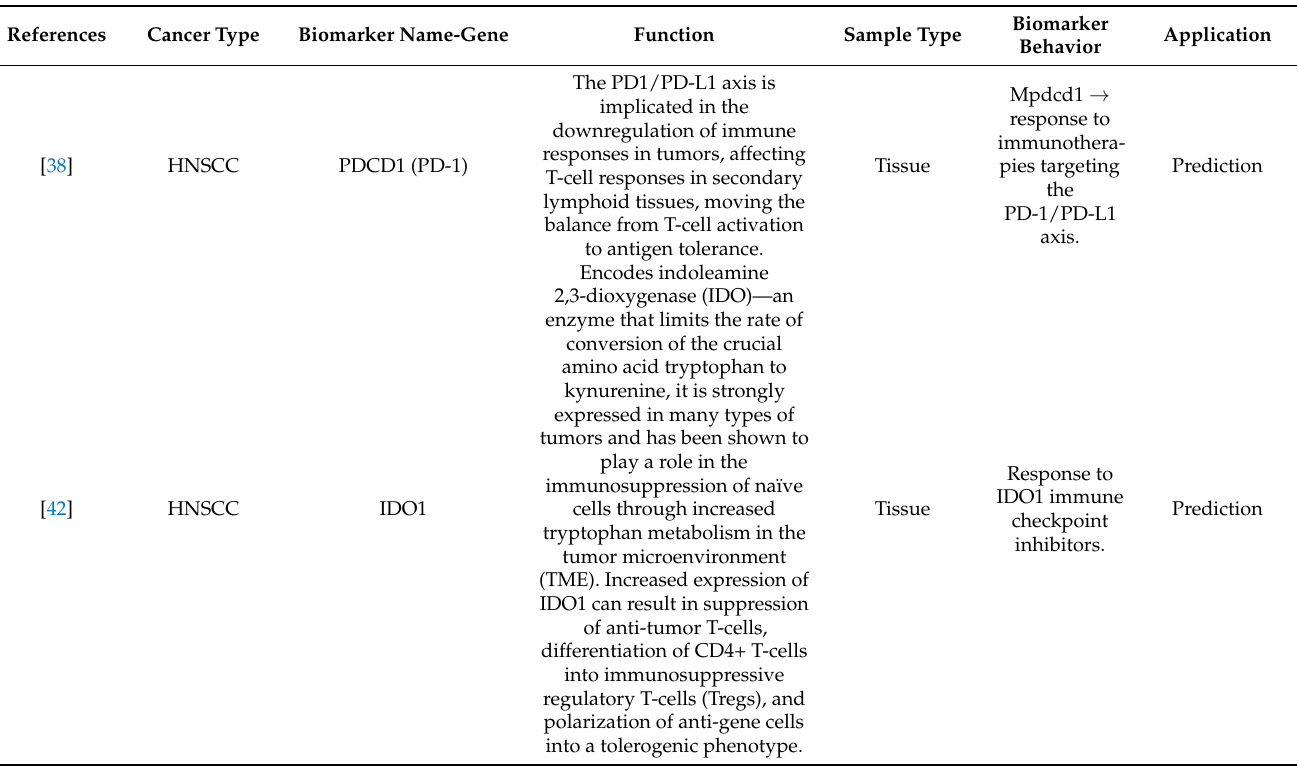
Table 3. Predictive